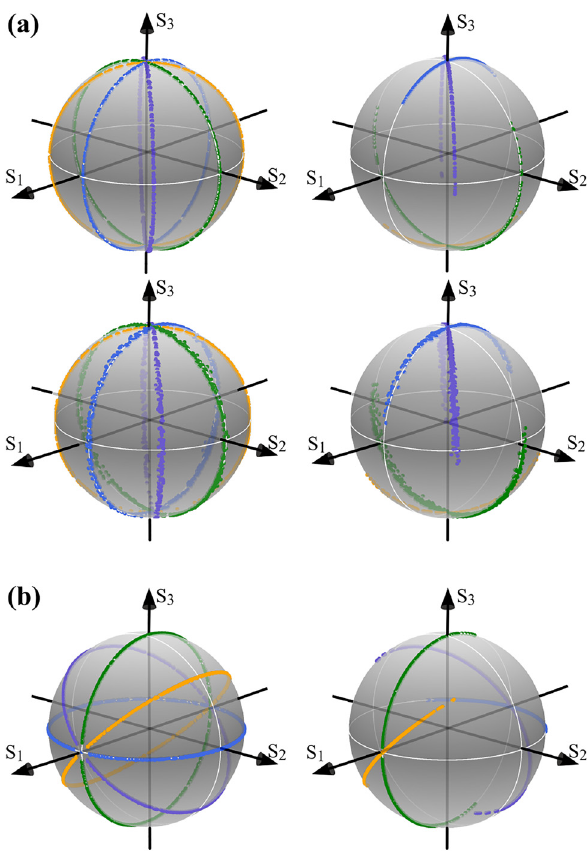
Figure 5: Geometric representation on the Poincaré sphere of the transverse polarisation distribution of the vector mode ( 𝜂,𝜉, z = 0) for (a) circular (numerical simulations on top and AVW 0 , 2 experiment on the bottom) and (b) horizontal/vertical polarisation basis. The left column shows the case of increasing values of the inter-modal phase, namely 𝛽 = 0 (blue), 𝛽 = 𝜋 ∕ 4 (purple), 𝛽 = 𝜋 ∕ 2 Figure 4: Vector quality factor (VQF) as a function of the weighing coefficient 𝛼 ∈ [ 0 ,𝜋 ∕ 2 ] for the mode AVW (green) and 𝛽 = 3 𝜋 ∕ 4 (yellow). The right column shows modes with ( 𝜂,𝜉, z = 0). Insets 2 , 3 show the intensity and polarisation distributions for 𝛼 = 0 ,𝜋 ∕ 4 and different weighting coefficients, namely 𝛼 = 𝜋 ∕ 12 ,𝜋 ∕ 6 ,𝜋 ∕ 4 and 𝜋 ∕ 2. 𝜋 ∕ 3, with the same inter-modal phases as in the left